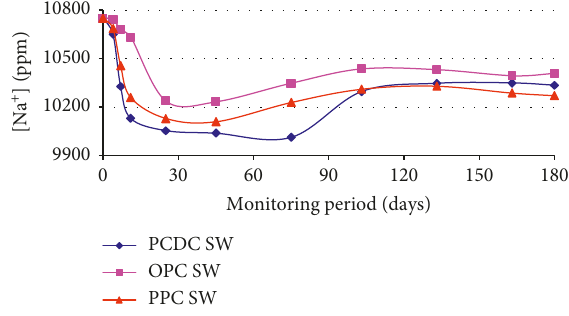
Figure 21: K + analyses in sea water.